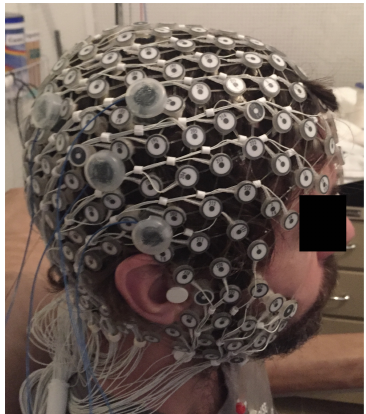
Figure 1. Position of the HD-tDCS electrodes and EEG 256-channel sensor net in a male participant. Written informed consent was obtained from the participants for the publication of this